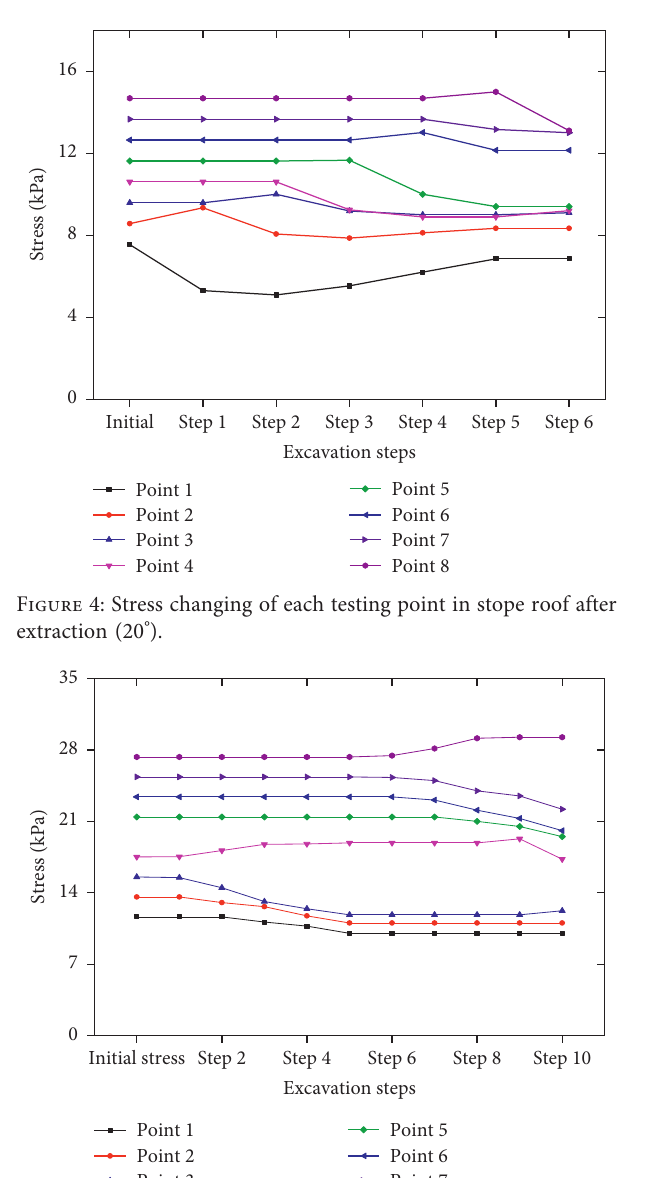
Figure 3: Layout of observation point about strata movement of physical model of one-one-eight exploration line of the east mining area of the sixth pithead of Jinning Phosphate Mine. (a) 20 ° inclination. (b) 50 ° inclination.